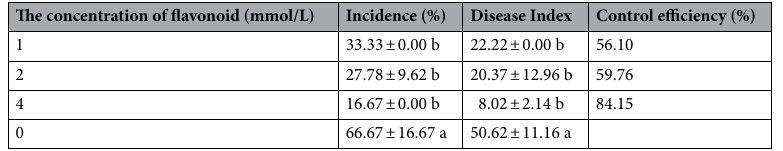
Table 3. The control efficiency of flavonoids on tobacco bacterial wilt. Different lowercase letters indicated that the disease incidence and disease index of TBW showed significant differences at P < 0.05 among different